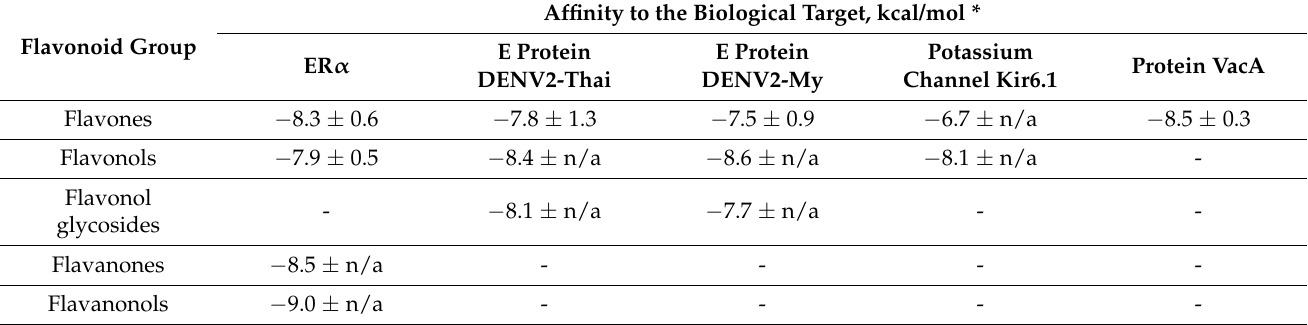
Table 3. Comparison of the average affinity of flavonoid groups to target proteins in the AutoDock.